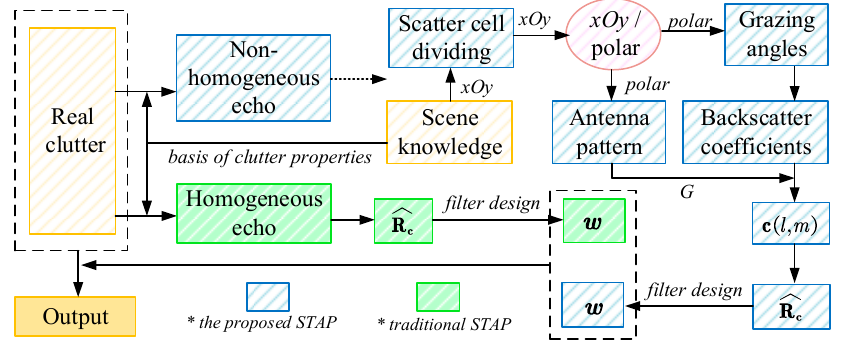
Figure 6. The flow diagram of traditional and proposed Space-time Adaptive Processing (STAPs) application.